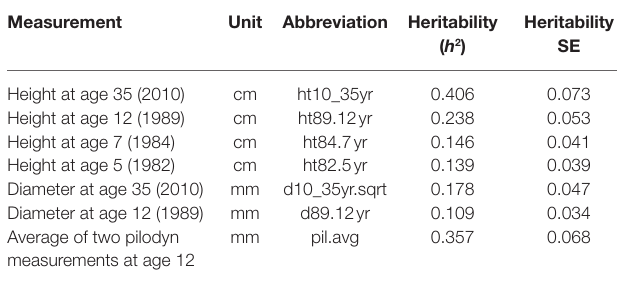
TABLE 2 | Ground-based measurements used in this analysis along with measurement units, measurement abbreviation, narrow-sense heritability ( h 2 ) estimates, and heritability standard error (SE).